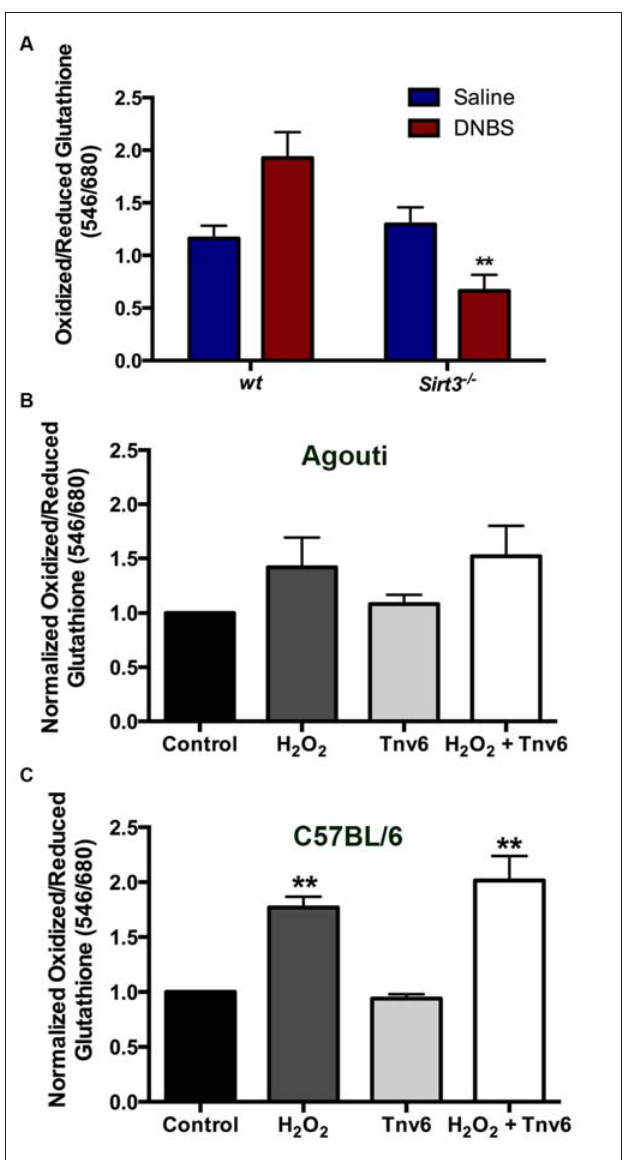
FIGURE 9 | Neither the ablation of Sirt3 nor the inhibition of Sirt3 has a significant effect on myenteric neuron redox balance. (A) Thiol oxidation measurements (ratio of oxidized/reduced glutathione) in myenteric neurons from saline or DNBS-treated wild type ( wt ) and Sirt3 − / − animals ( n = 3–5 animals, ∗∗ P < 0.01 vs. wt DNBS-treated, ANOVA). (B,C) Neuronal thiol oxidation measurements in whole-mount preparations from (B) wt agouti mice and (C) wt C57BL/6 mice treated with the oxidative stressor hydrogen peroxide (H 2 O 2 ) and/or the Sirt3 inhibitor Tenovin-6 (Tnv-6, 100 µ m; n = 3 animals, ∗∗ P < 0.01,